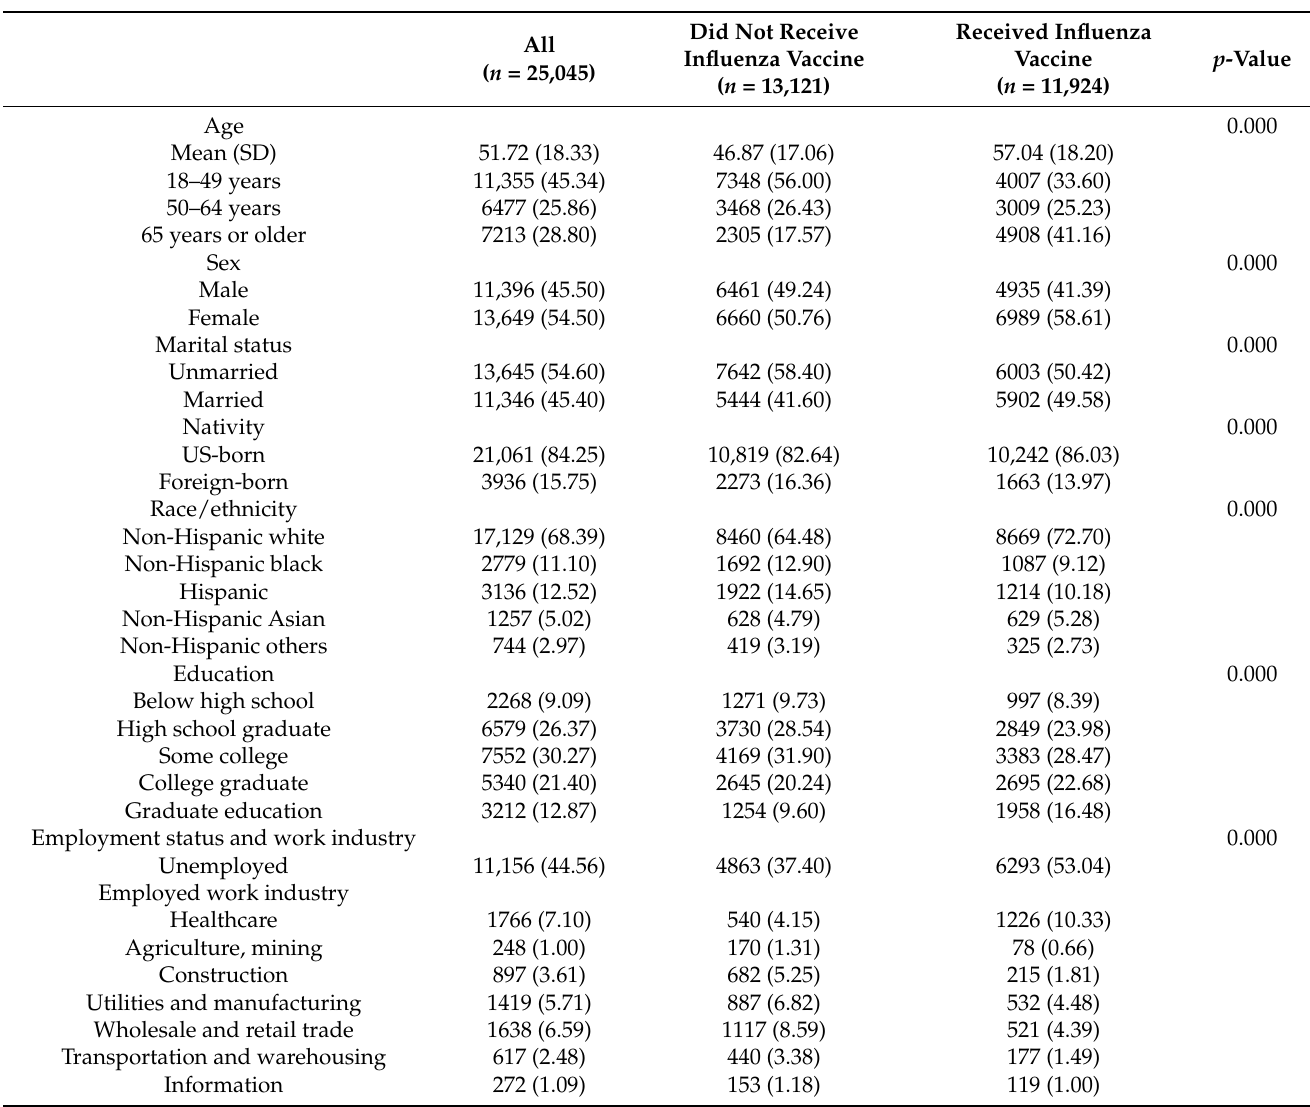
Table 1. Demographic characteristics of survey